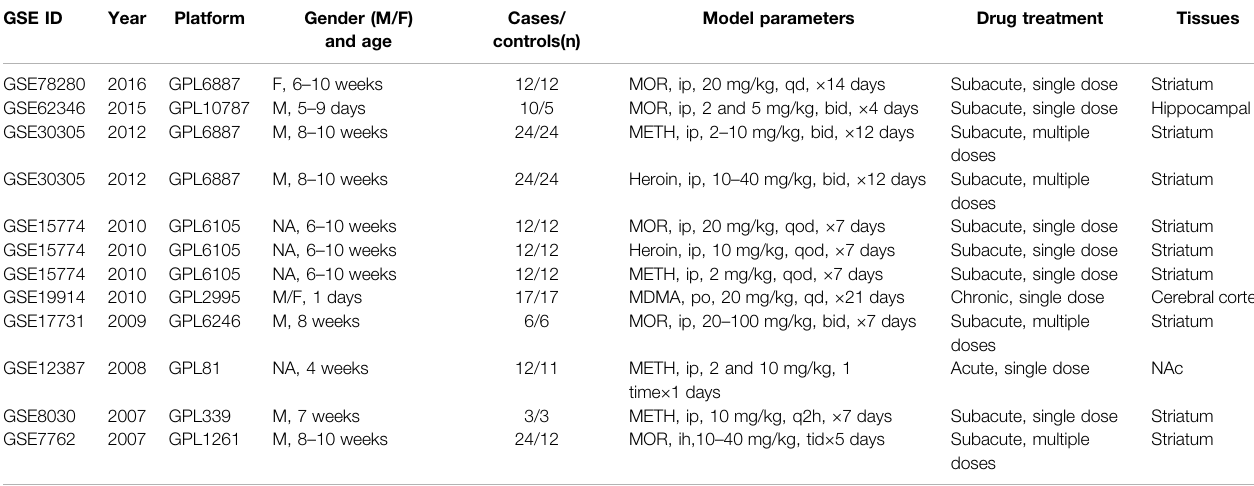
TABLE 1 | Basic information of the selected databases in the